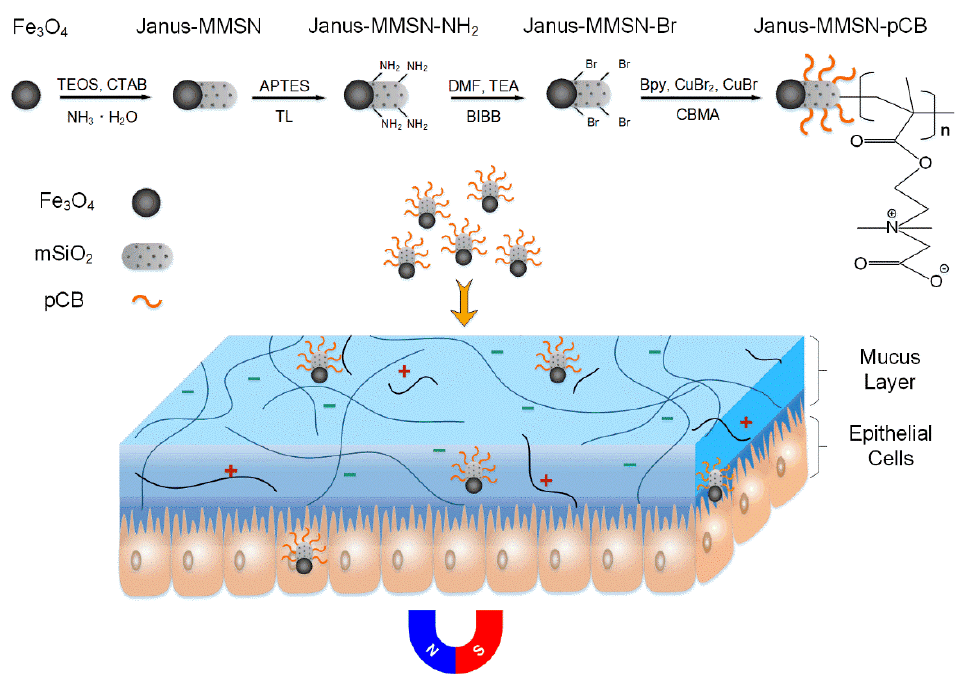
Figure 1. Schematic illustration of the synthesis of magnetically driven, muco-inert Janus-MMSN- pCB nanovehicles. (TEOS: tetraethyl orthosilicate; CTAB: hexadecyl trimethyl bromide ammonium; APTES: 3- aminopropyltriethoxysilane; TL: toluene; DMF: N,N′ -dimethylformamide; TEA: triethyl amine; BIBB: α - bromoisobutyryl bromide; Bpy: 2′ -bipyridine; CBMA: carboxybetaine methacrylate; pCB: poly(carboxybetaine methacrylate); mSiO 2 : mesoporous SiO 2 .)